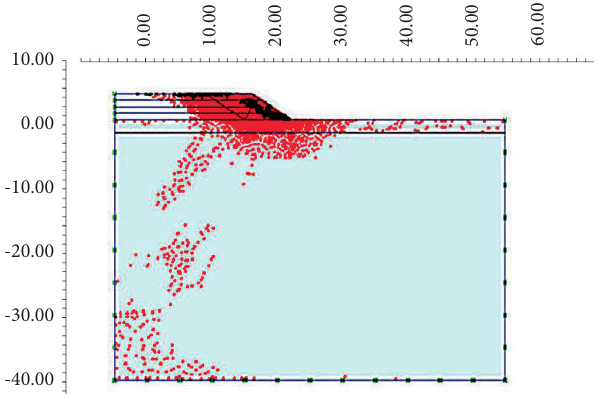
Figure 11: Plastic zone in the limit state.